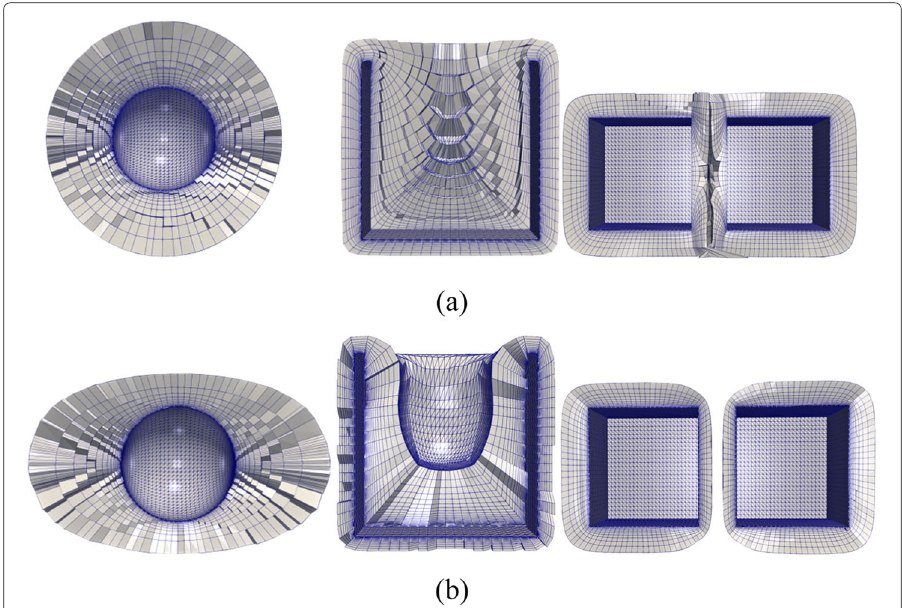
Fig. 4 Illustration of the prismatic meshes. ( a ) The prismatic meshes induced by standard volume harmonic field; ( b ) The prismatic meshes induced by the proposed anisotropic volume harmonic